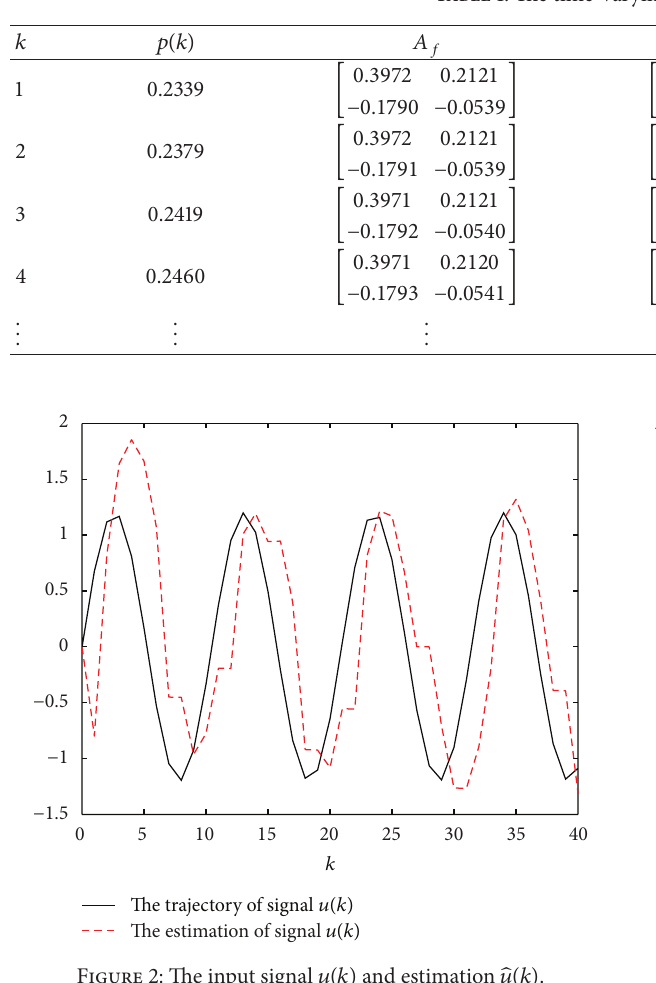
Figure 2: The input signal 𝑢(𝑘) and estimation ̂𝑢(𝑘) .